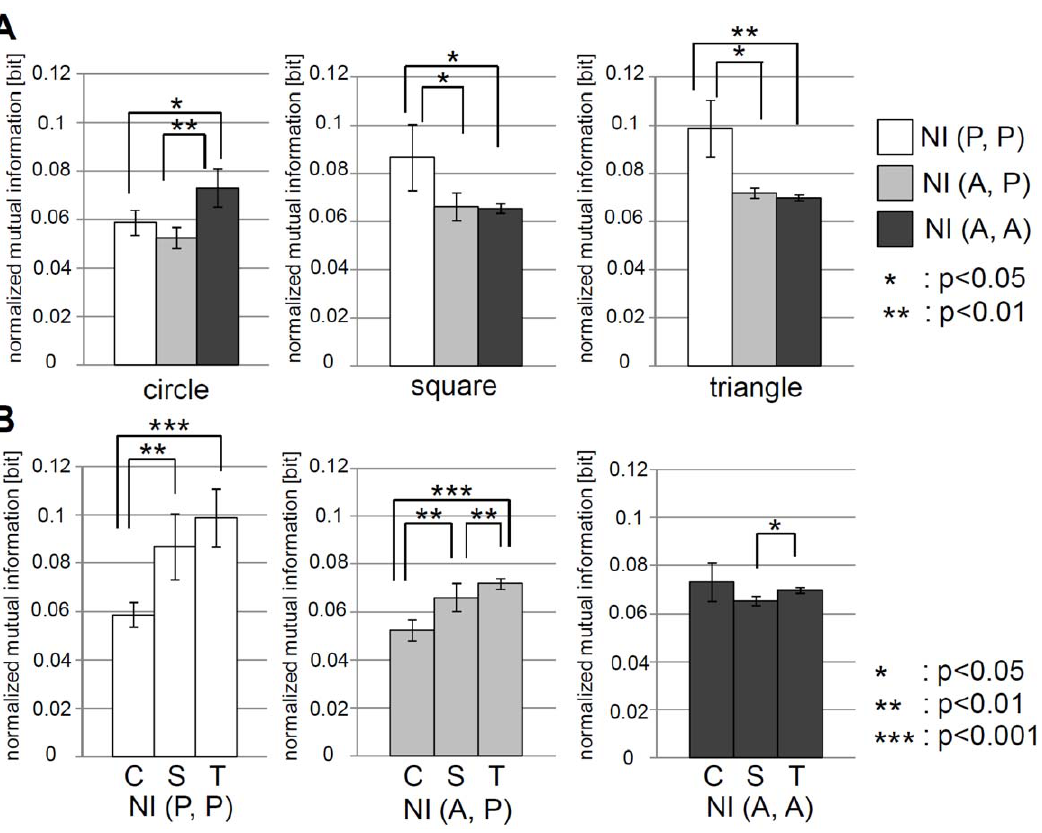
Figure 7. Comparisons of normalized mutual information ( NI ( P , P ) , NI ( A , P ) , and NI ( A , A ) ). A. Comparisons of normalized mutual information in the circular (left), square (middle), and triangular (right) cases. To calculate the normalized mutual information, we used the last 1200 timesteps for all the pairs of ( P , P ) (15 pairs), ( A , P ) (36 pairs), and ( A , A ) (15 pairs), in each trial. The plots show the averaged value over all the trials. The error bars show the standard deviation. In the circular case, NI ( P , P ) , NI ( A , P ) , and NI ( A , A ) are 0.059 + 0.005 bits, 0.052 + 0.004 bits, and 0.073 + 0.008 bits, respectively. In the square case, NI ( P , P ) , NI ( A , P ) , and NI ( A , A ) are 0.087 + 0.014 bits, 0.066 + 0.006 bits, and 0.065 + 0.002 bits, respectively. In the triangular case, NI ( P , P ) , NI ( A , P ) , and NI ( A , A ) are 0.099 + 0.012 bits, 0.072 + 0.002 bits, and 0.070 + 0.001 bits, respectively. B. Comparisons of the circular, square, and triangular cases for NI ( P , P ) , NI ( A , P ) , and NI ( A , A ) . The same plots of A. are rearranged. For A. and B. , asterisks indicate significant differences, (cid:2) : p v 0 : 05 , (cid:2)(cid:2) : p v 0 : 01 , and (cid:2) (cid:2) (cid:2) : p v 0 : 001